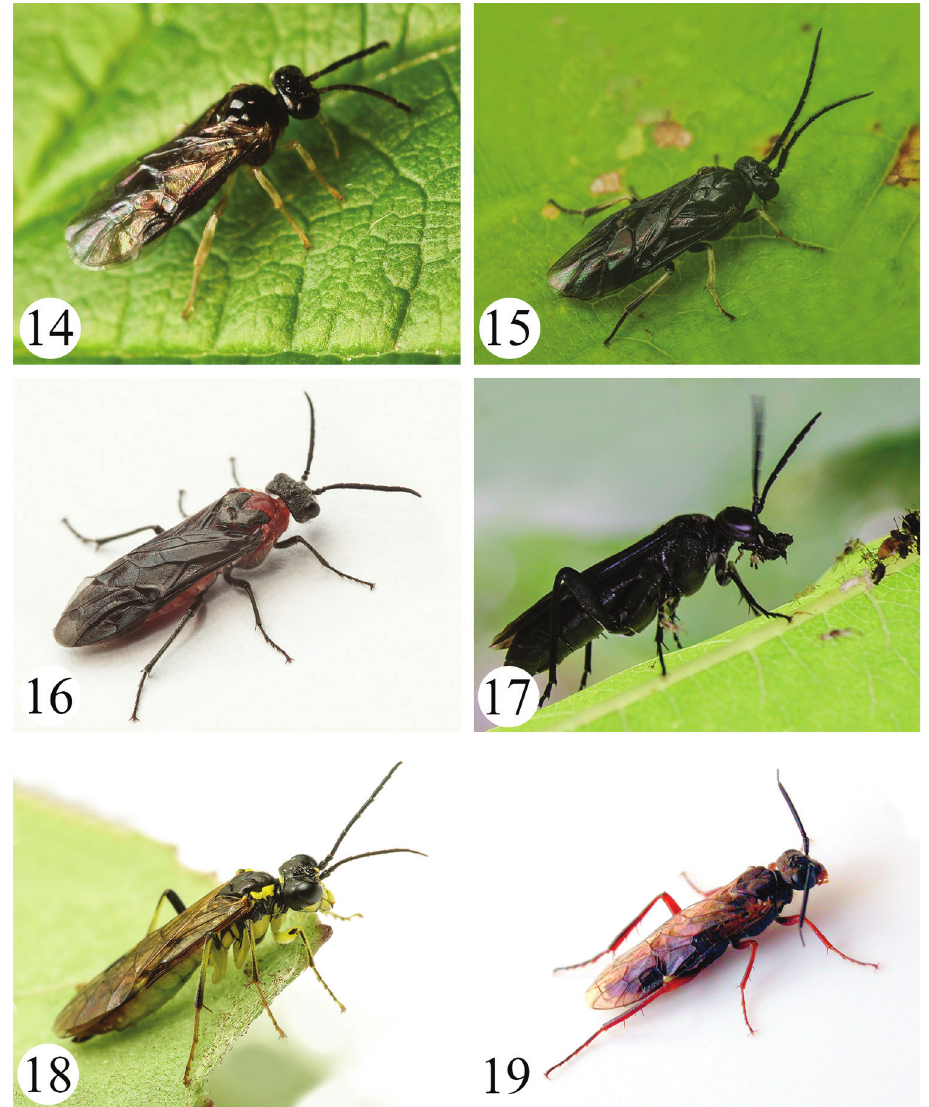
Figures 14–19. Sawfly adults 14 Metallus capitalis (Tenthredinidae: Heterarthrinae), Driftwood Prov. Park, ON, Canada 15 Cladius pallipes , Manitoulin Island, ON, Canada 16 Dolerus ( Achaetoprion ) sp. (Tenthredinidae: Selandriinae), Manitoulin Island, ON, Canada 17 Lagium atroviolaceum (Tenthredini- dae: Tenthredininae) feeding on aphids (Hemiptera: Aphididae), Gore Bay, ON, Canada 18 Tenthredo pleuralis (Tenthredinidae: Tenthredininae), St. Anthony, NF, Canada 19 Macroxyela ferruginea (Xyelidae), Maryland, USA (photo by S.